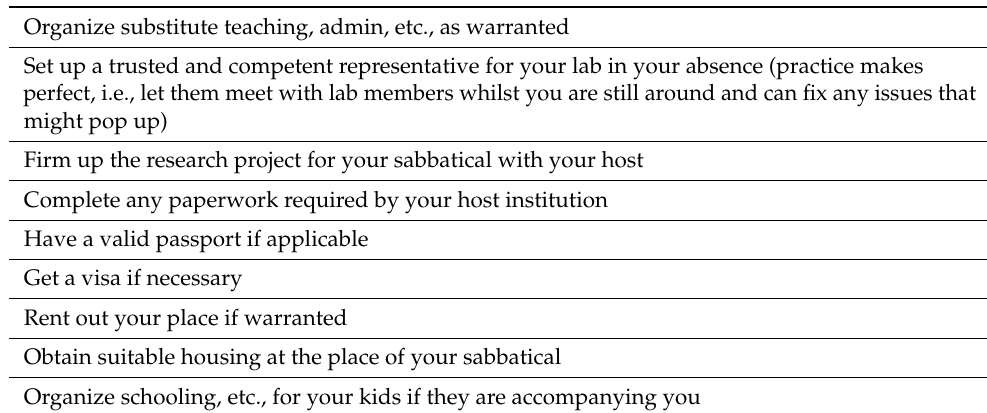
Table 3. In the year before your